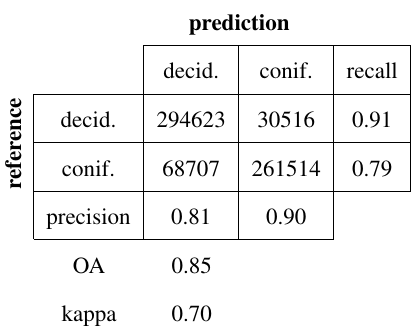
Table 2. Classification result (epoch 163) for applying the trained neural network on randomly chosen test data; OA = overall accuracy, decid. = deciduous, conif. = coniferous Figure 3. Cubic blocks used for training of PointNet++; 3D points colored in dependence of the class labels ”coniferous” (blue) and ”deciduous”